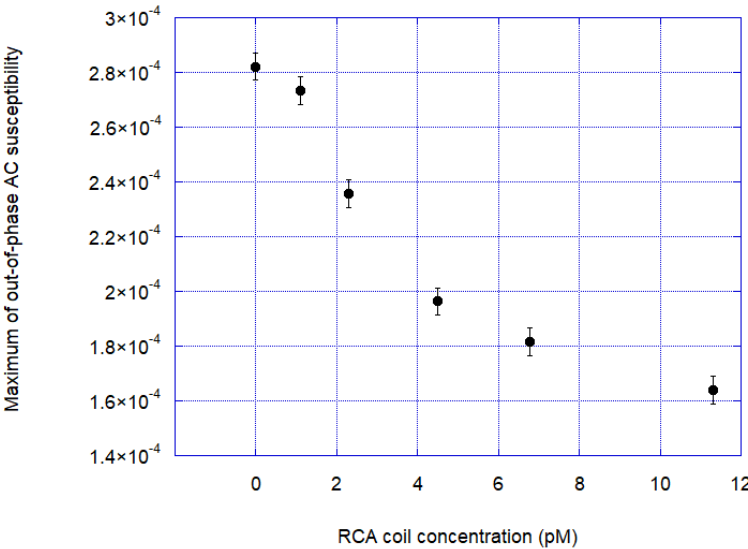
Figure 5. Out-of-phase signal at the Brownian relaxation peak versus RCA coil concentration. Errors bars at each data points are determined from measurements of the signal standard deviation ( σ ) at the Brownian relaxation frequency (~100 Hz) and is defined by 3 σ (about 10 − 5 volume susceptibility SI units).